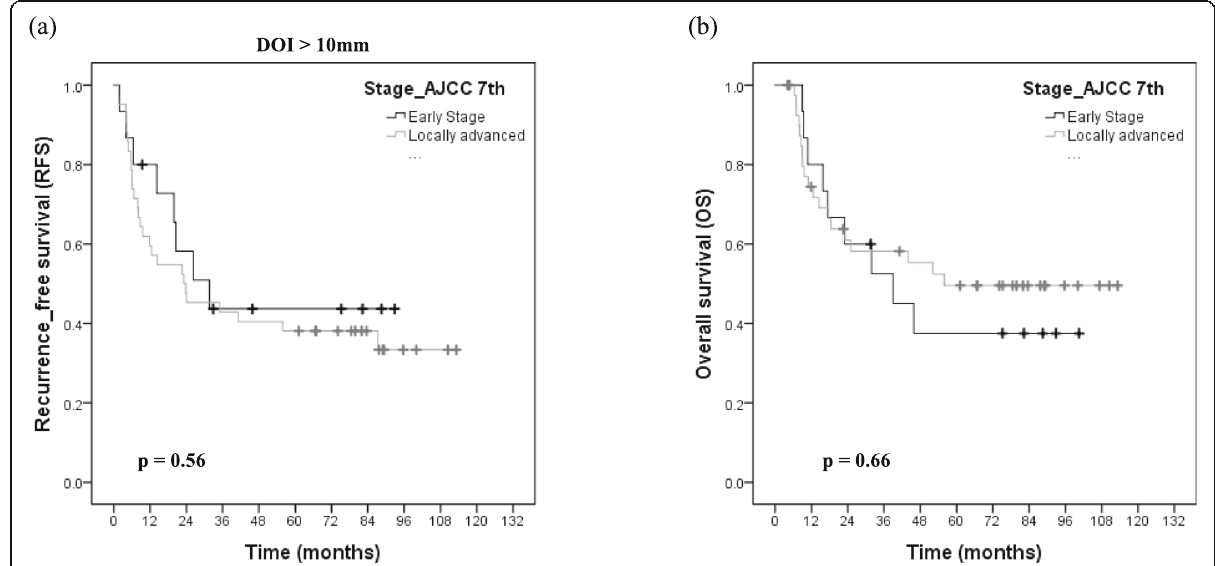
Fig. 4 Kaplan-Meier analysis showing recurrence-free survival ( a ) and overall survival ( b ) stratified by stage of disease in patients with (DOI) greater than 10